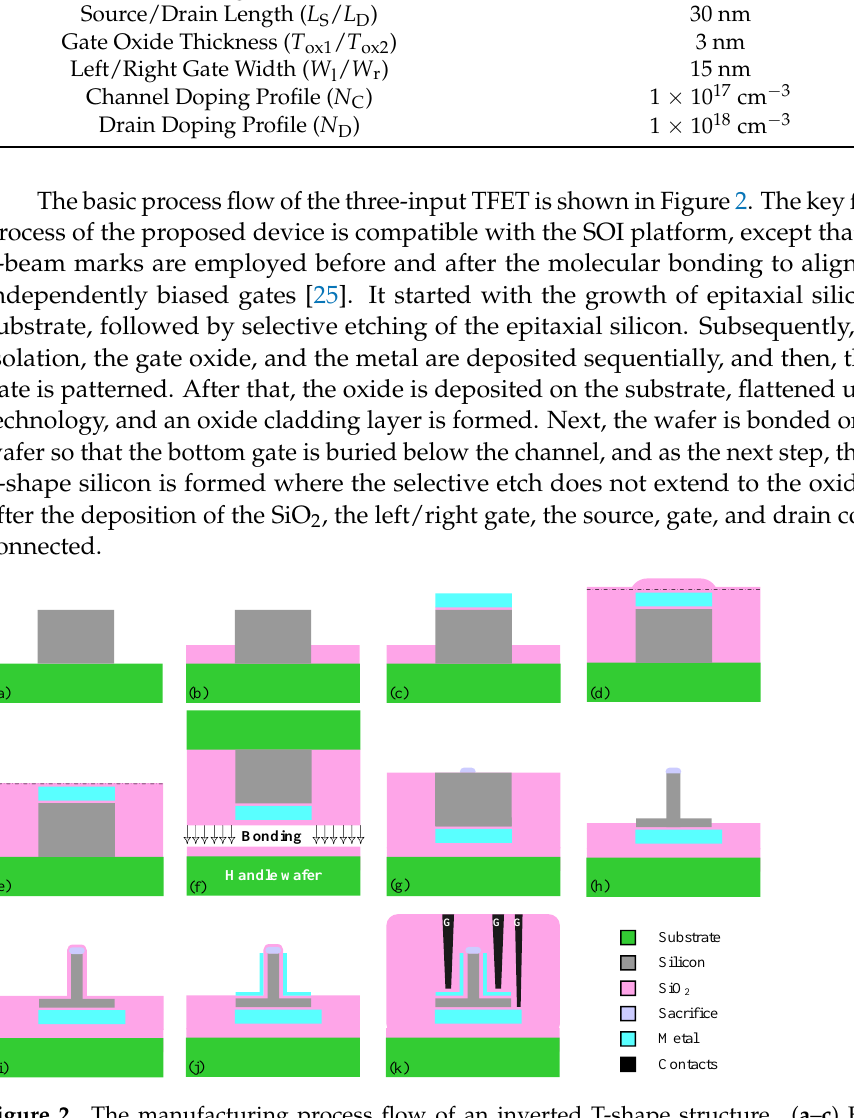
( b ) Figure 3. ( a ) Potential distribution (extracted by TCAD) along the XX’ cutline for increasing V RG from 0.2 V to 1.0 V in steps of 0.1 V, where V BG is fixed at 0.8 V. ( b ) Simplified model of the potential along the XX’ cutline. All cutlines lie in the YZ plane, and the YY’ and ZZ’ cutlines indicate the surface potential near the right and bottom gates, respectively.